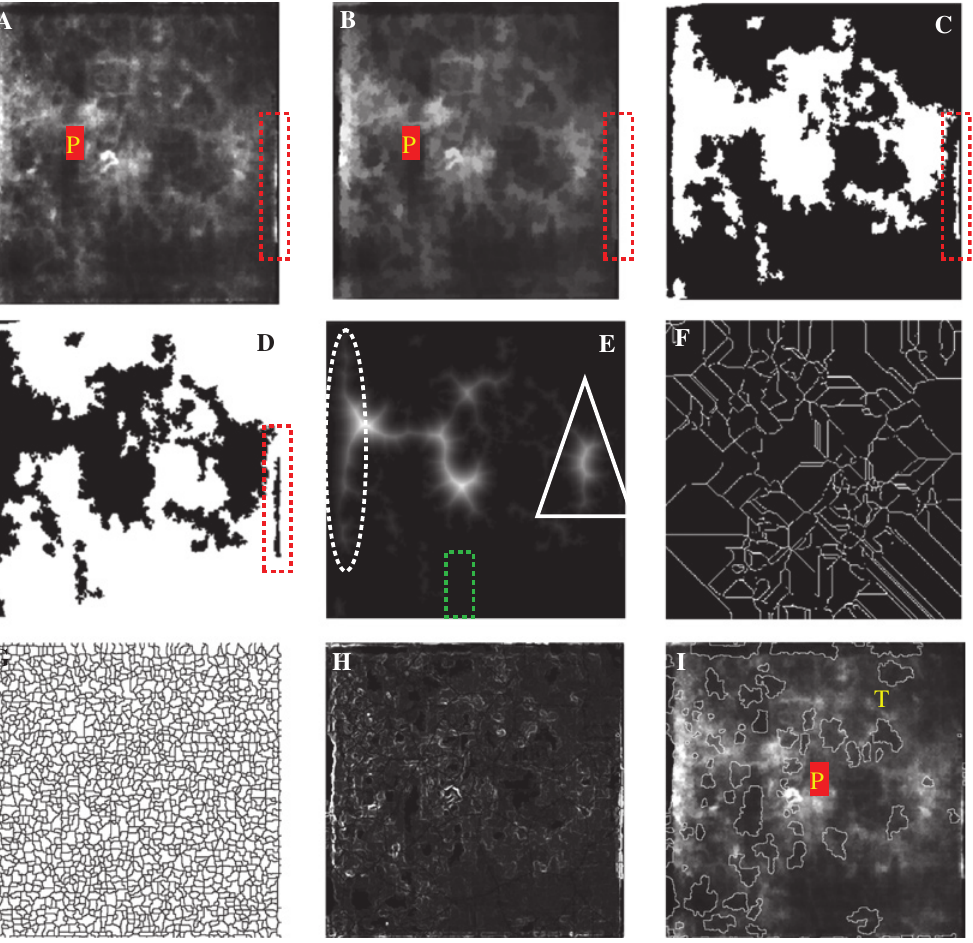
, (B) preprocessed image by morphological operator, (C) binary processing image, (D) complement of binary image, (E) Figure 12 (A) EOF 10 distance transform, (F) image of watershed ridge line, (G) watershed – gradient, (H) watershed – gradient and marker controlled, (I) super- imposed – watershed (GM) and original